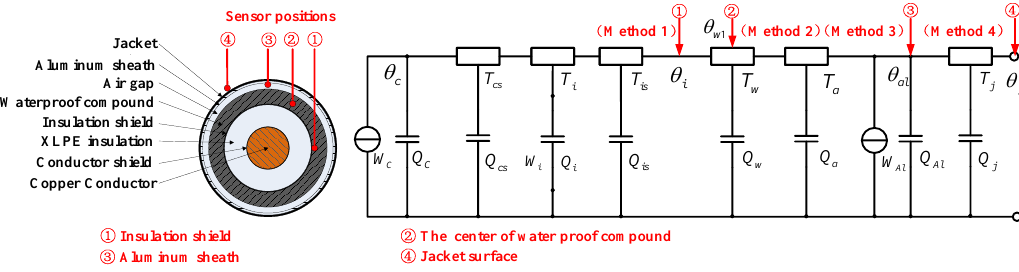
Figure 2. Radial positions of temperature sensor and corresponding thermal circuit in a cable.